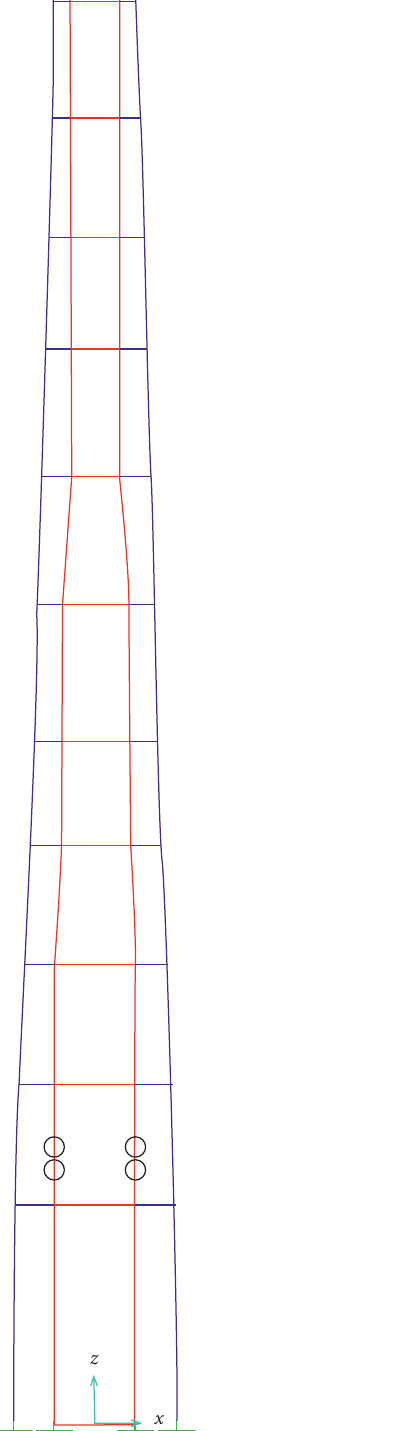
Figure 21: FEM of the simplified model in SAP2000.